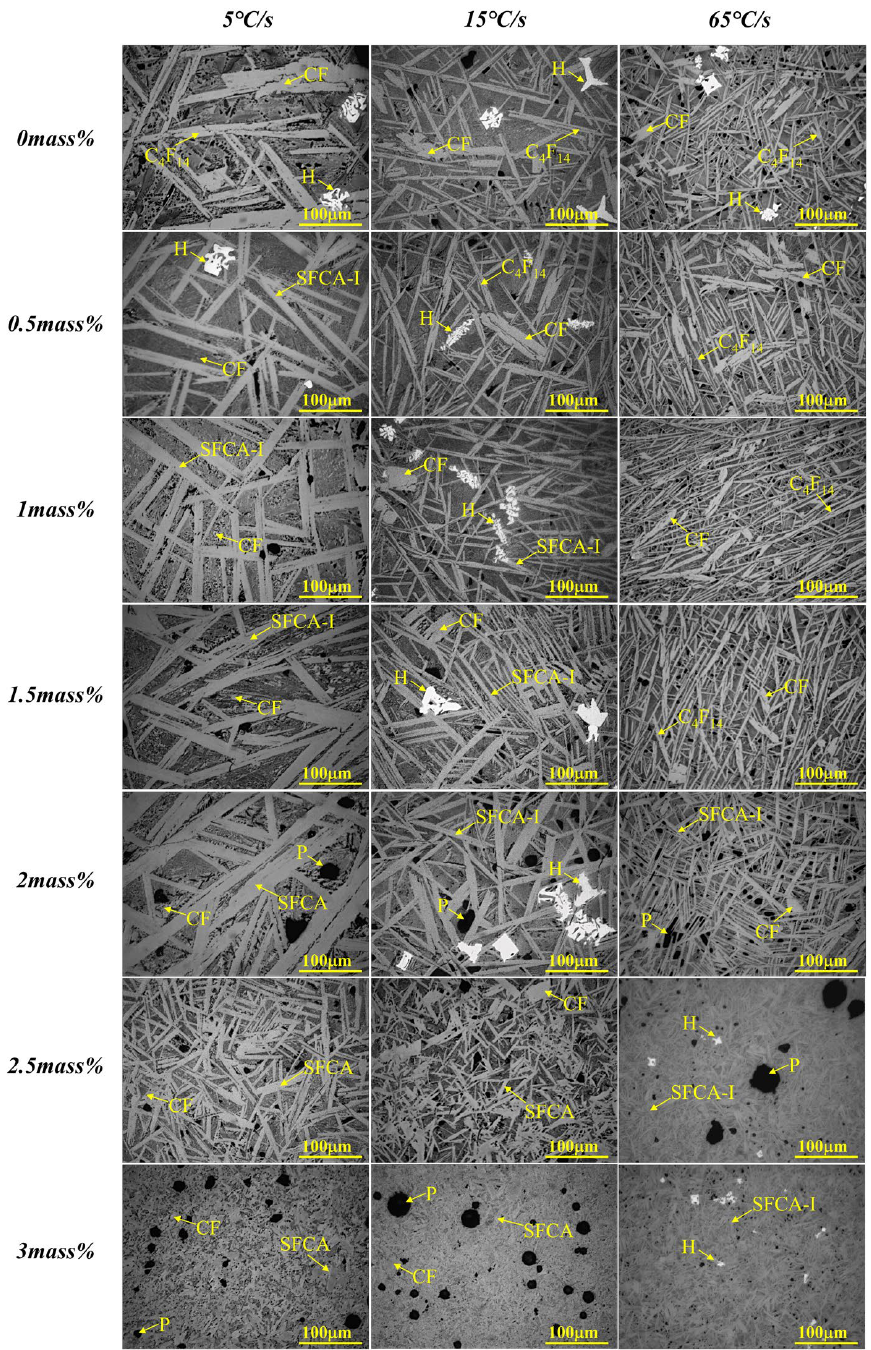
Figure 11. Optical micrographs of cross-sections of crystalline samples with Al 2 O 3 addition at vari- cooling rates. C 4 F 14 : (Ca 4 Fe 14 O 25 ); CF: CaFe 2 O 4 ; SFCA-I: Ca 3.18 Fe 15.48 Al 1.34 O 36 ; SFCA: Ca 5 Si 2 (Fe ous cooling rates. C 4 F 14 : (Ca 4 Fe 14 O 25 ); CF: CaFe 2 O 4 ; SFCA-I: Ca 3 . 18 Fe 15 . 48 Al 1 . 34 O 36 ; SFCA: Ca 5 Si 2 (Fe Al) 18 O 36 ; H: Fe 2 O 3 ; P: Al) 18 O 36 ; H: Fe 2 O 3 ; P: Pore.